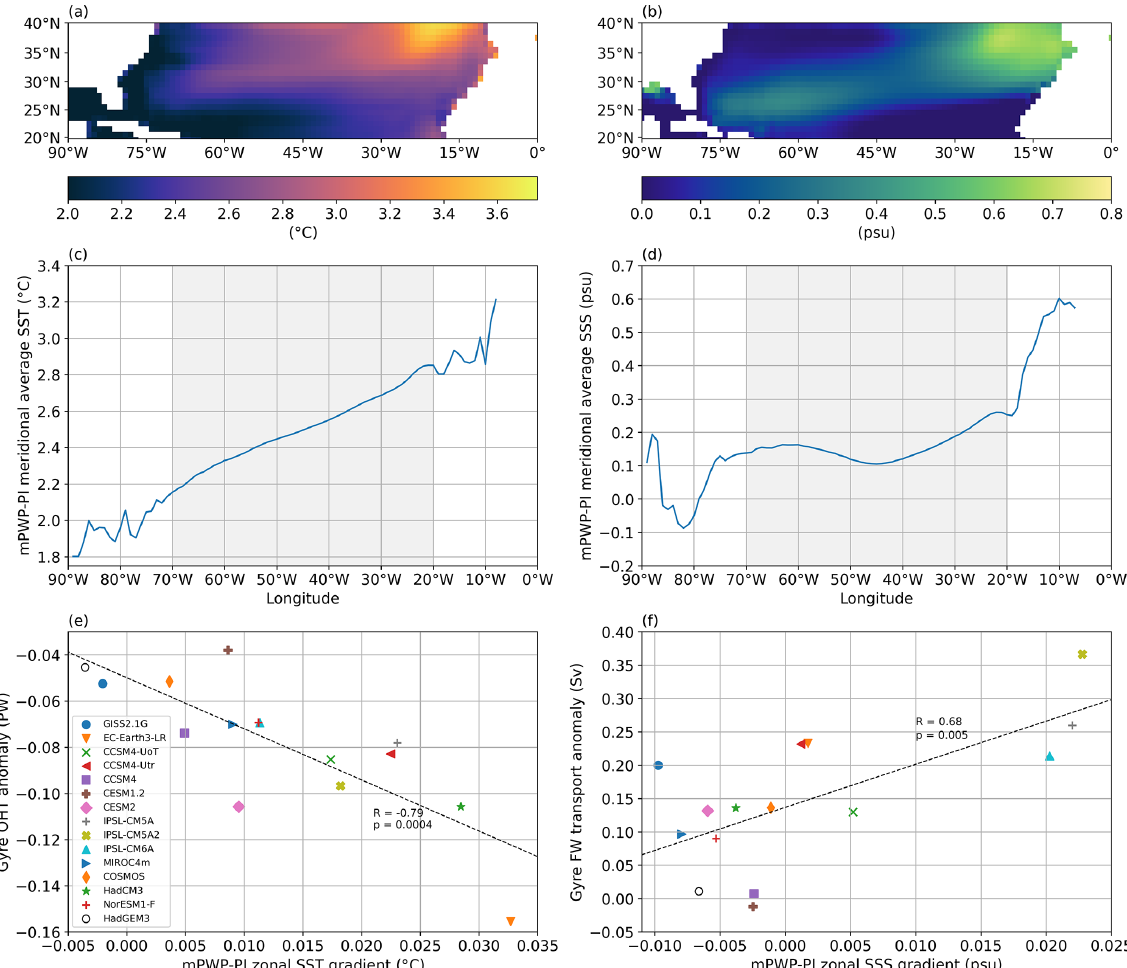
Figure 13. (a) MMM mPWP–PI Atlantic SST difference between 20–40 ◦ N. (b) MMM mPWP–PI Atlantic SSS difference between 20– 40 ◦ N. (c) MMM 20–40 ◦ N meridional-mean mPWP-PI Atlantic SST difference. (d) MMM 20–40 ◦ N meridional-mean mPWP-PI Atlantic SSS difference. (e) Individual model mPWP–PI mean difference in zonal SST gradient from (c) between 20–70 ◦ W plotted against